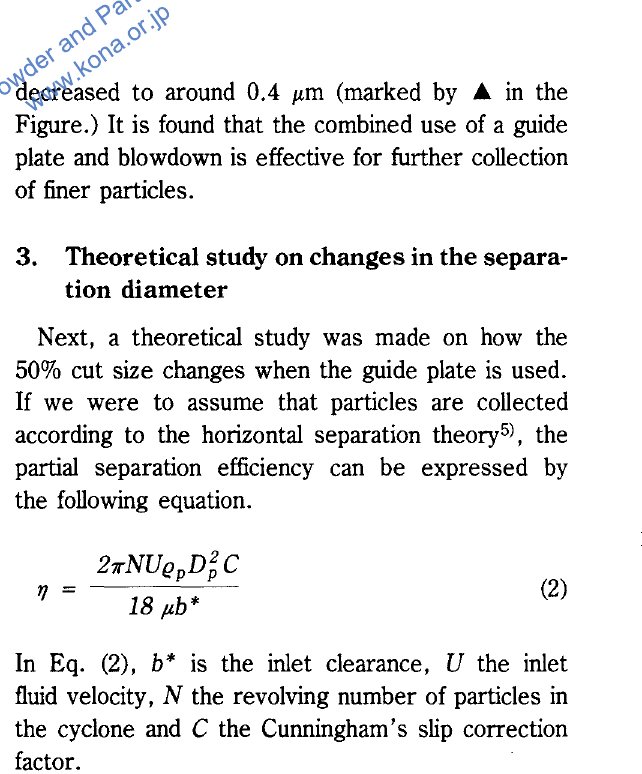
Fig. 9 Effect of guide plate and blow down on partial separation efficiency